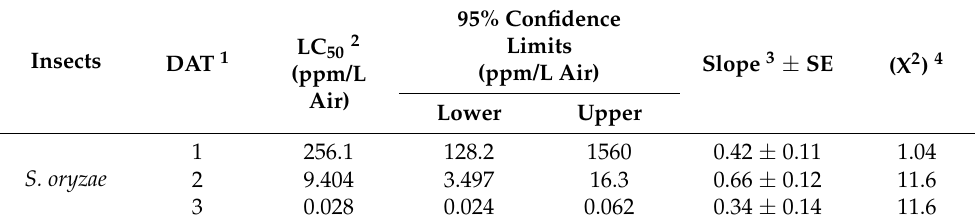
Table 9. LC 50 values of R. officinalis oil recorded against S. oryzae and T. castaneum adults following fumigation